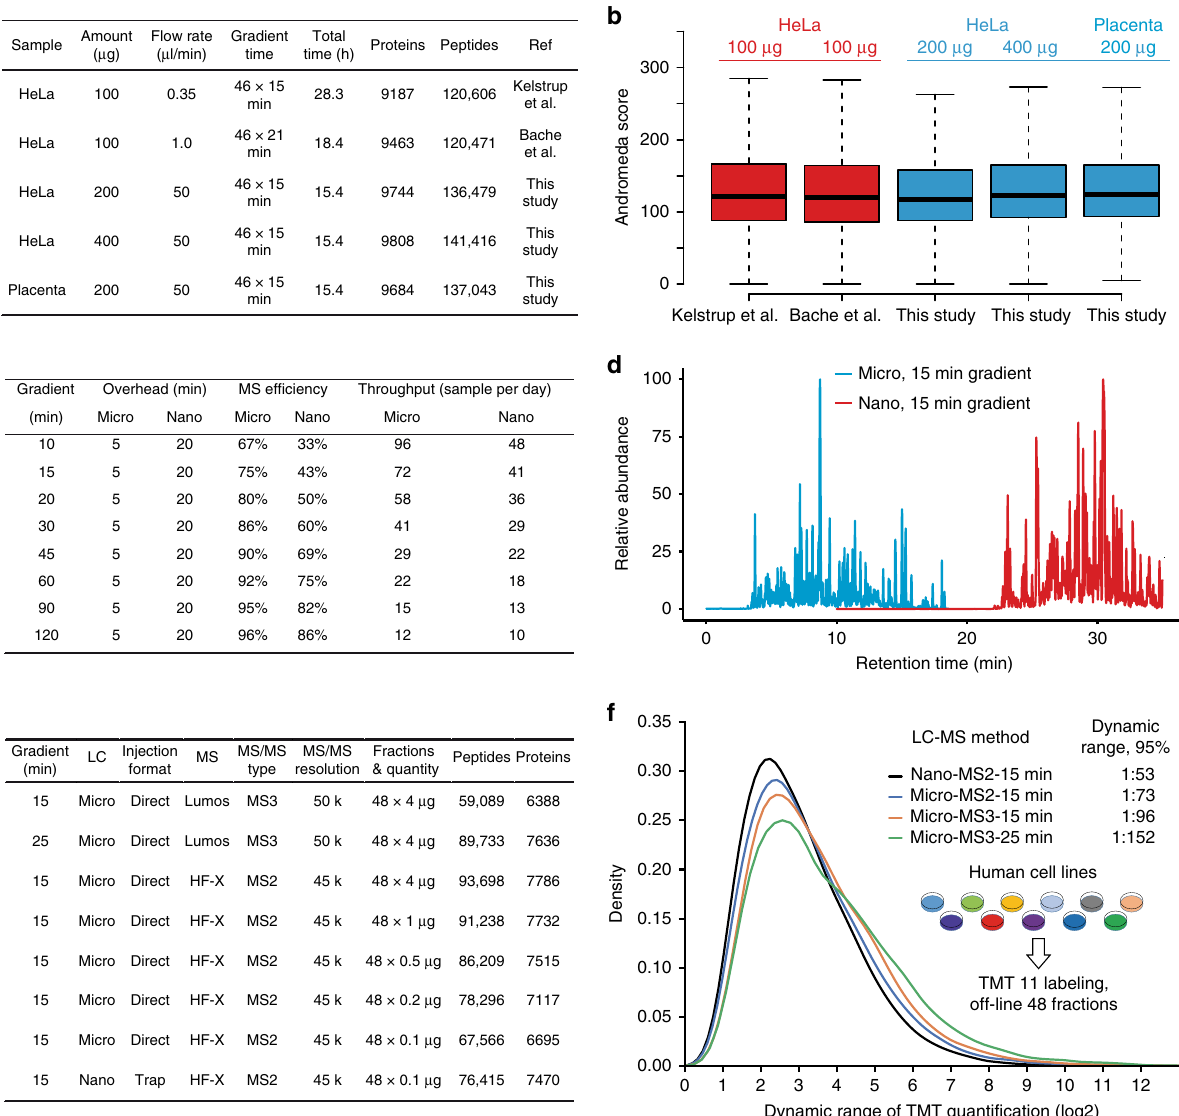
Fig. 2 Deep-scale proteome analysis of the micro- fl ow LC – MS/MS system. a Summary of key experimental paramters and results comparing deep-scale proteome analysis data of HeLa and placenta protein digests using published nano- fl ow LC – MS/MS data and data obtained by micro- fl ow LC – MS/MS data in this study. b Box plots comparing Andromeda peptide identi fi cation scores of the data shown in a . Boxes and whiskers are de fi ned as in Fig. 1b. The number of peaks used for each box are 303,597 (Kelstrup et al. 31 ), 282,215 (Bache et al. 29 ), 287,834 (This study, 200 µ g HeLa), 304,278 (This study, 400 µ g HeLa), and 276,306 (This study, Placenta). Boxes and whiskers are de fi ned as in Fig. 1b. Source data are provided as a Source Data fi le for b . c Summary of the actual sample throughput that can be achieved by the micro- fl ow LC – MS/MS system presented in this study compared to a typical nano- fl ow LC – MS/MS setup. d Overlay of base peak chromatograms of the same high pH reversed phase chromatography fraction of a TMT11 labeled pepties from a deep-scale analysis of 11 human cancer cell lines analyzed by micro- fl ow (blue) and nano- fl ow (red) LC – MS/MS, each using a 15 min gradient. e Result summary for the deep-scale proteomic analysis of eleven TMT-multiplexed human cancer cell lines using nano- fl ow or micro- fl ow LC – MS/MS systems. f Density plot displaying the dynamic range of TMT quanti fi cation for common peptides from 11 human cancer cell lines obtained by measuring identical samples using the LC – MS/MS con fi gurations as shown in e . Dynamic range of TMT quanti fi cation was de fi ned as the ratio of the maximum and minimum intensity values of a peptide across the 11 TMT quanti fi cation between the 11 human cell lines (Fig. 2f). Speci fi - cally, dynamic range (de fi ned to cover 95% of all protein expression ratios between cell lines, see methods) increased from 1:50 (nano- fl ow) to 1:75 (micro- fl ow) for MS2 measurements, to 1:100 (micro- fl ow) for MS3 measurements all using 15 min gra- dients, and to 1:150 (micro- fl ow) when extending the gradient time from 15 to 25 min (Fig. 2f). These above results demonstrate that deep-scale proteome analysis of higher organisms can be envisaged at a throughput of 11 – 16 proteomes per day.